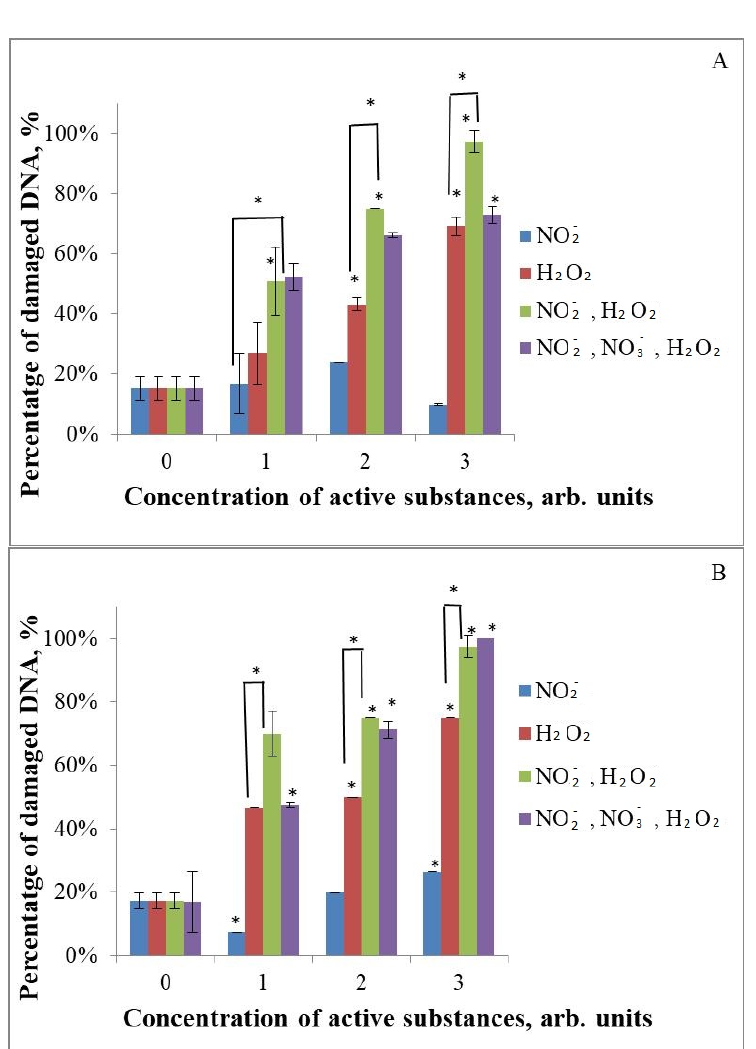
Figure 10. Dependence of the level of DNA damage of ( A ) conventionally healthy and ( B ) tumor (mieloblastosis) cells on the concentration of nitrites, nitrates, and hydrogen peroxide added to the nutritional medium. Concentrations 1–3 correspond to those in the physiological solution treated by the direct piezodischarge during 30, 60, and 90 s, respectively (1: H 2 O 2 —2.08 µM, NO 2 − —0.058 mM, NO 3 − —0.286 mM; 2: H 2 O 2 —6.91 µM, NO 2 − —0.091 mM, NO 3 − —0.378 mM; 3: H 2 O 2 –10.08 µM; NO 2 − —0.103 mM, NO 3 − —0.725 mM). An asterisk * indicates a statistically significant difference ( p < 0.05) from the control, an asterisk above the frame indicates a statistically significant difference ( p < 0.05) between different experimental samples. The experimental conditions are described in the Section